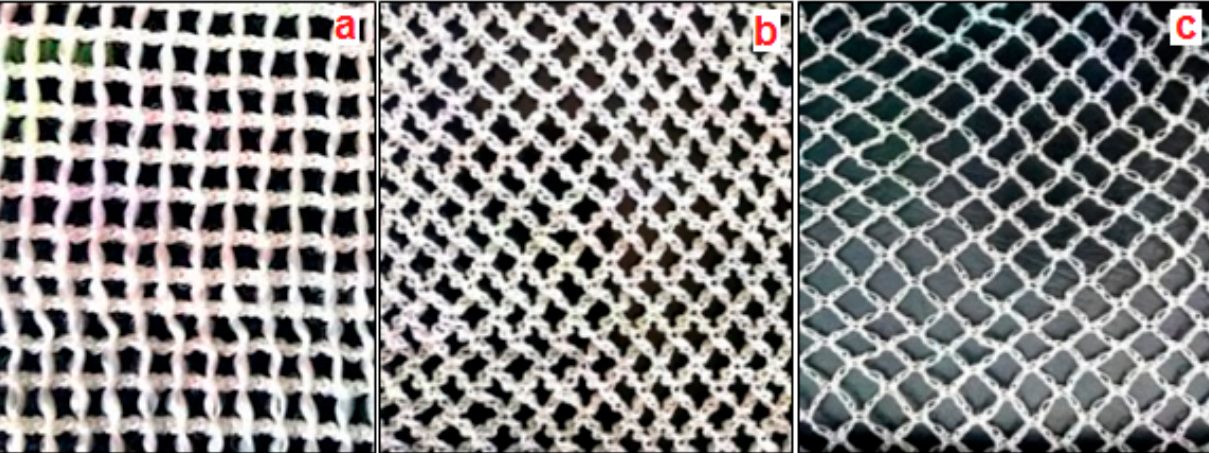
Figure 1. Chicken mesh.